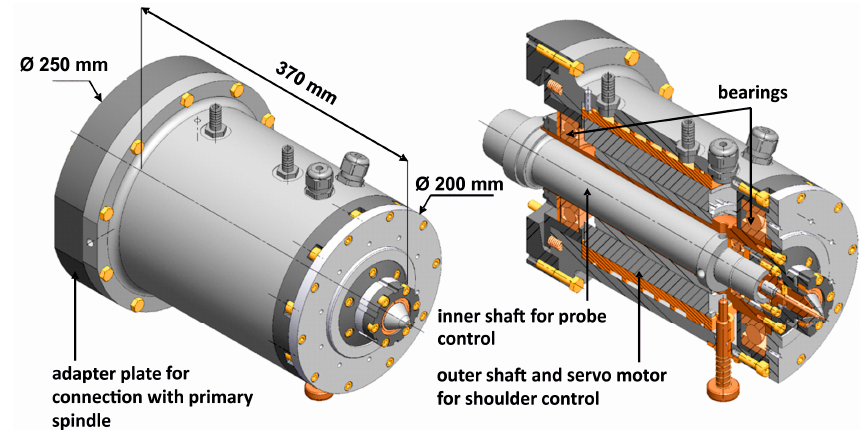
Figure 4. Schematic structure of the secondary spindle with inner and outer shaft to control shoulder and probe rotational speed and rotational direction.